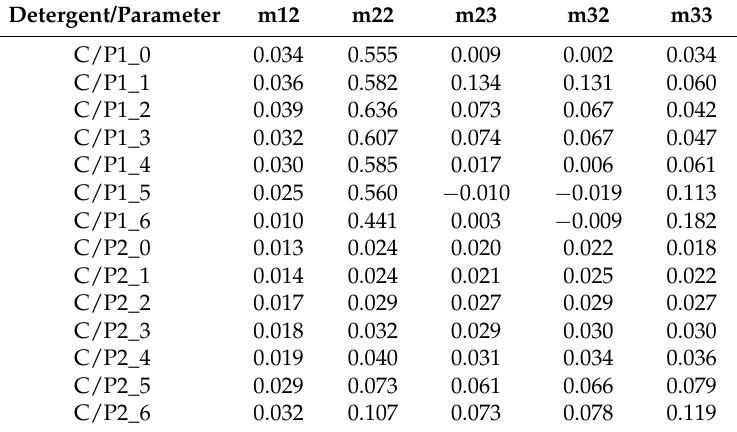
Table 4. Central moments P1 and P2 of the Mueller matrix elements for silk sample washed by color stain